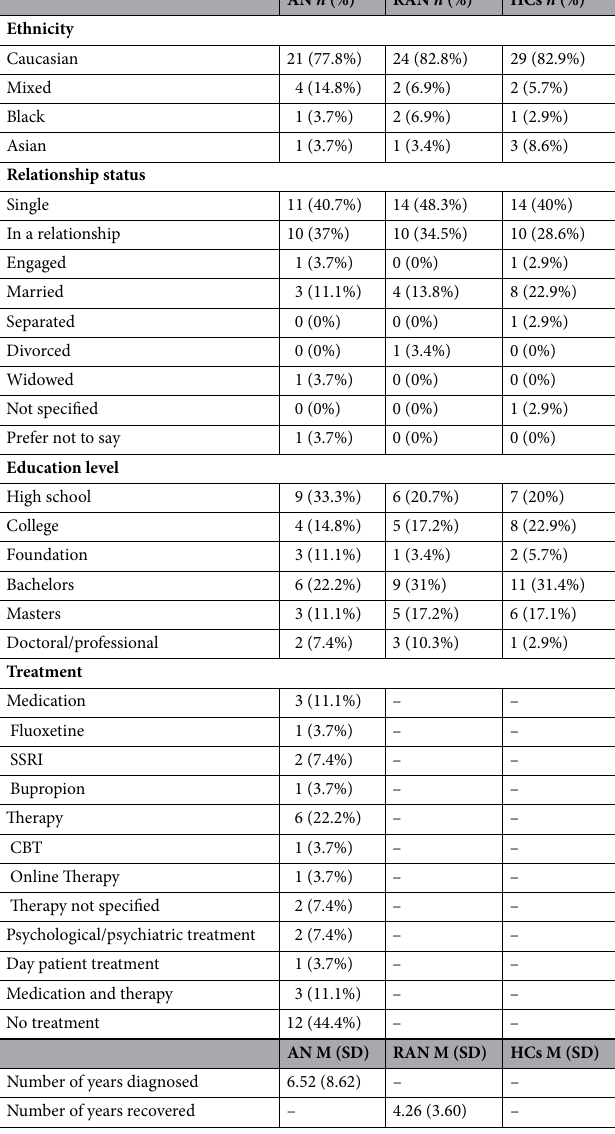
Table 2. Demographic characteristics of current anorexics ( n = 27) recovered anorexics ( n = 29) and HCs ( n = 35), which have been analysed by